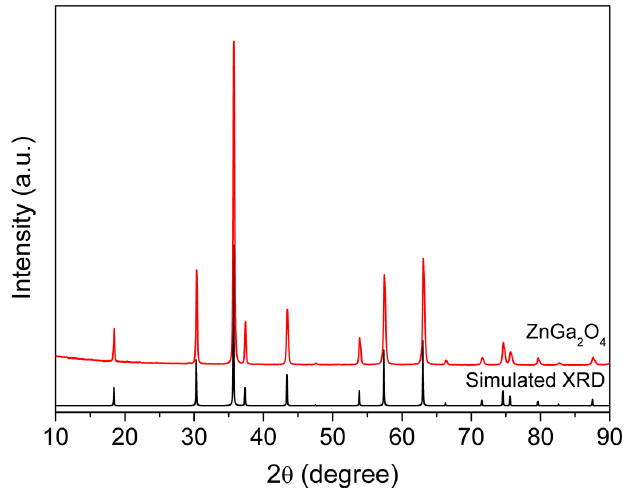
ff raction (XRD) pattern for the ZnGa